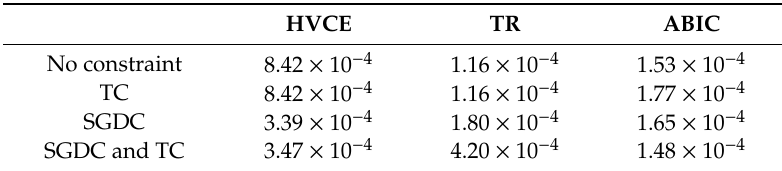
Table 2. Value of the regularization parameter k for di ff erent inversion methods with various constraints (i.e., the spatial GRACE data constraints (SGDC) and terrain-corrected GPS